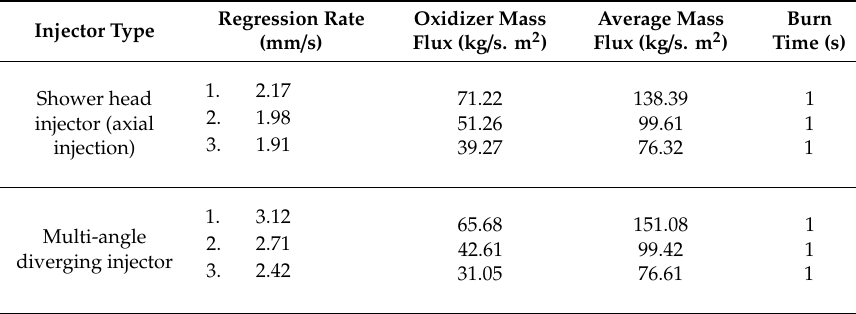
Table A2. Interrupted test firings for Para ffi n wax